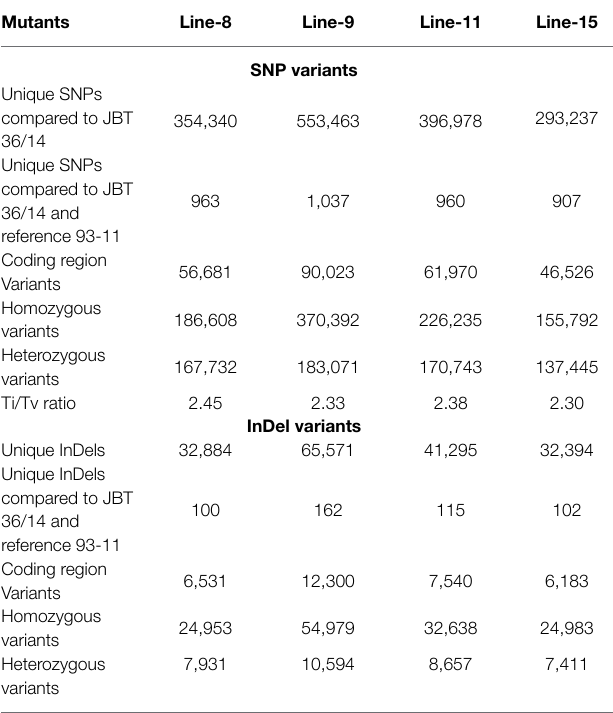
TABLE 4 | Summary of unique structural variations in mutant rice lines as compared to reference genome Oryza sativa ssp. indica 93-11 and JBT